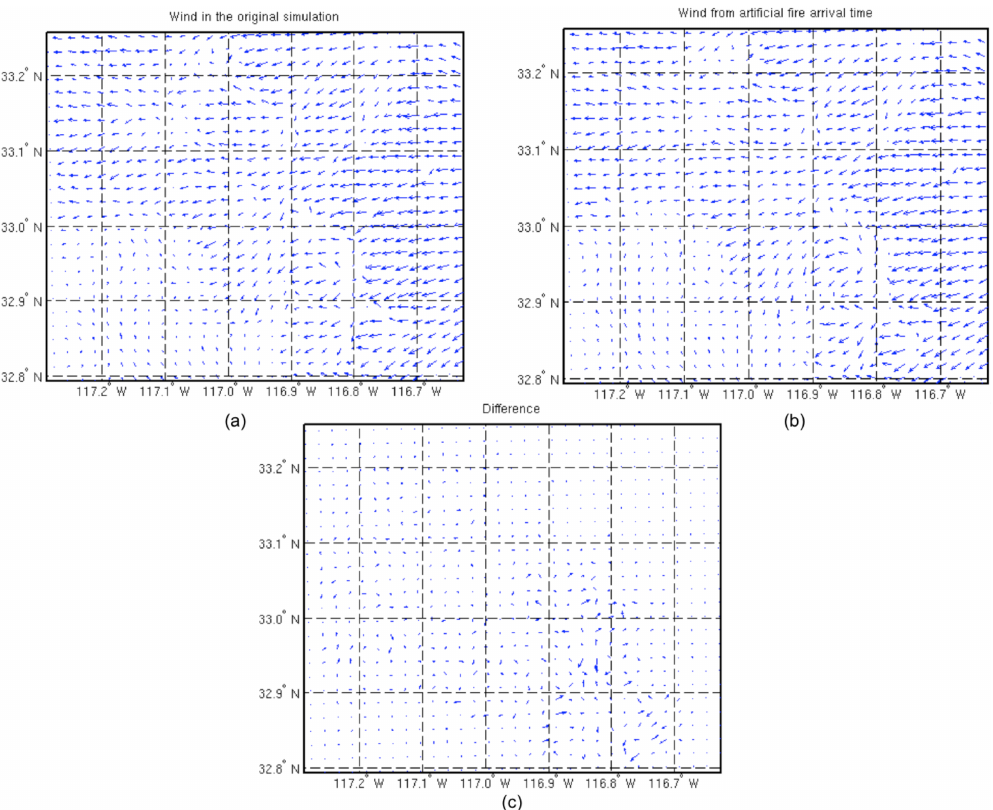
Figure 5. (a) Horizontal wind at 6.1m in the 2007 Santa Ana fires simulation on October 2007, 13:00PDT. (b) The same wind as in (a) , but with the artificial ignition time history from Fig. 4b until October 2007, 13:00PDT. The simulation with an artificial fire history, i.e., spin-up, does not use any fire-behavior data from an earlier time, yet the wind fields in each developed quite closely. (c) The difference of (a) and (b) . The root mean square error (RMSE) is 1.1ms − 1 , which is 8.8% of the maximal wind speed 12.53ms − 1 .